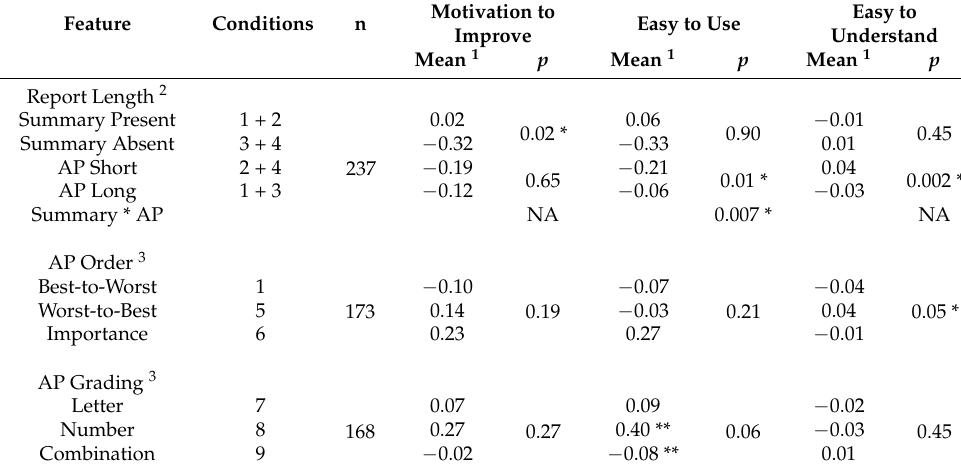
Table 4. Report length analyses